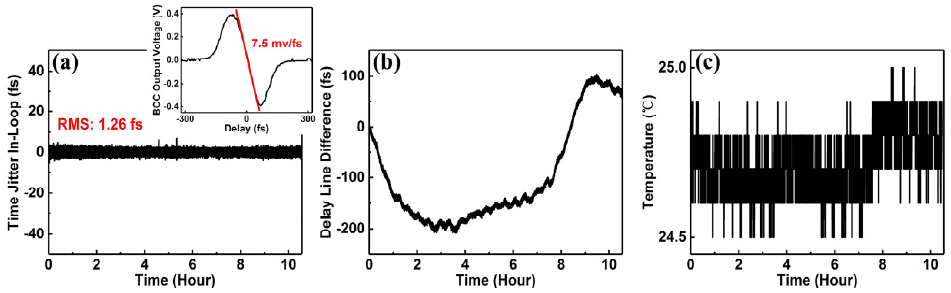
Figure 3. Synchronous pulses ( a ) without and ( b ) with optical path correction (curves in different colors represent different laser pulses).